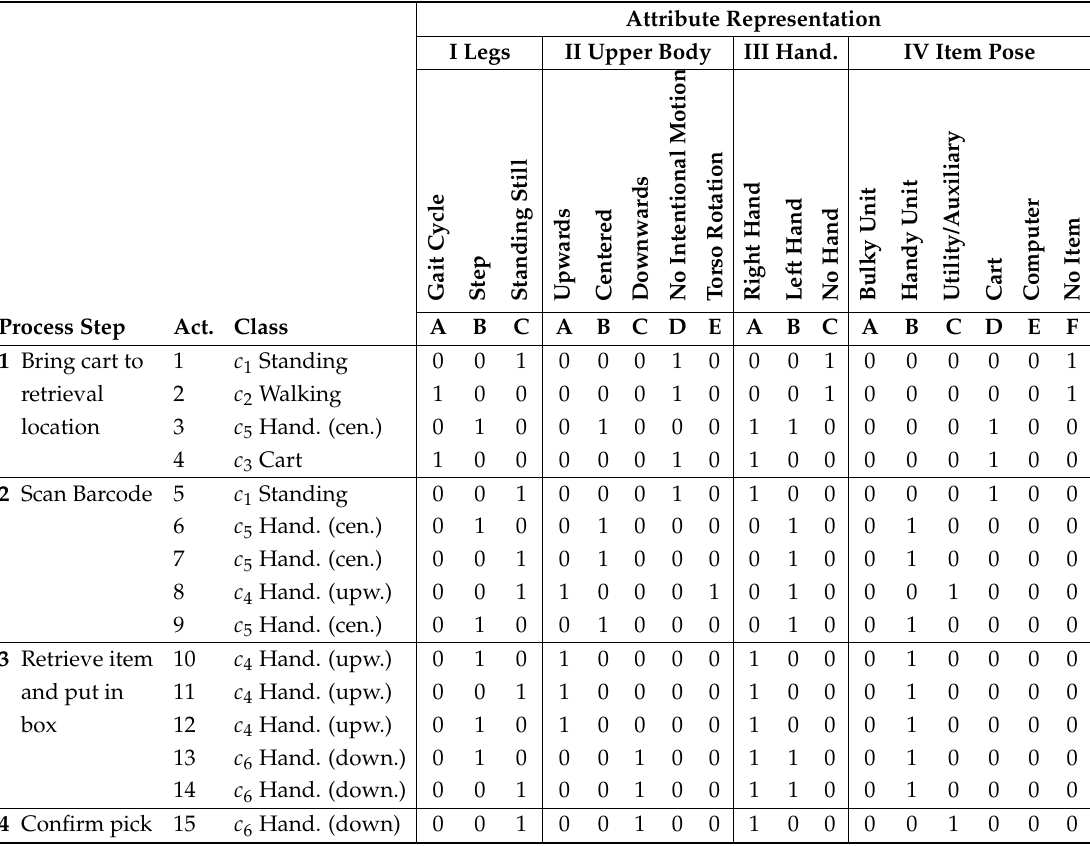
Table 4. Exemplary picking process broken down into process steps, activities, classes, and